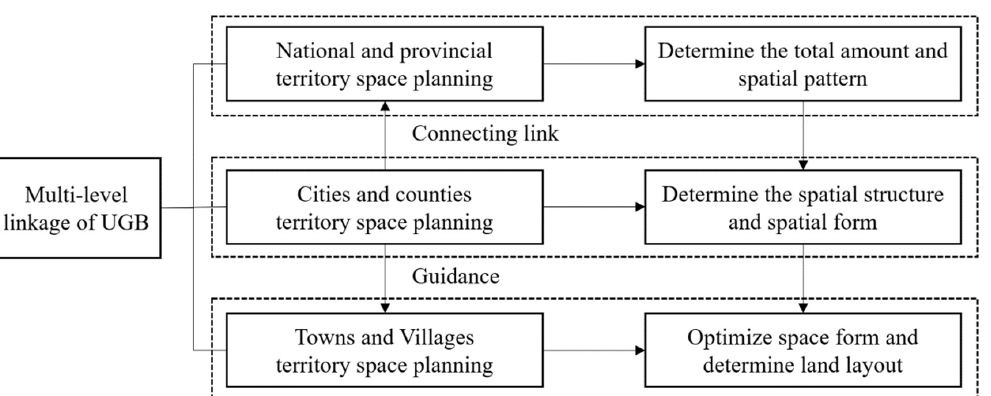
Figure 8. Multilevel planning framework of China’s urban development boundary system.